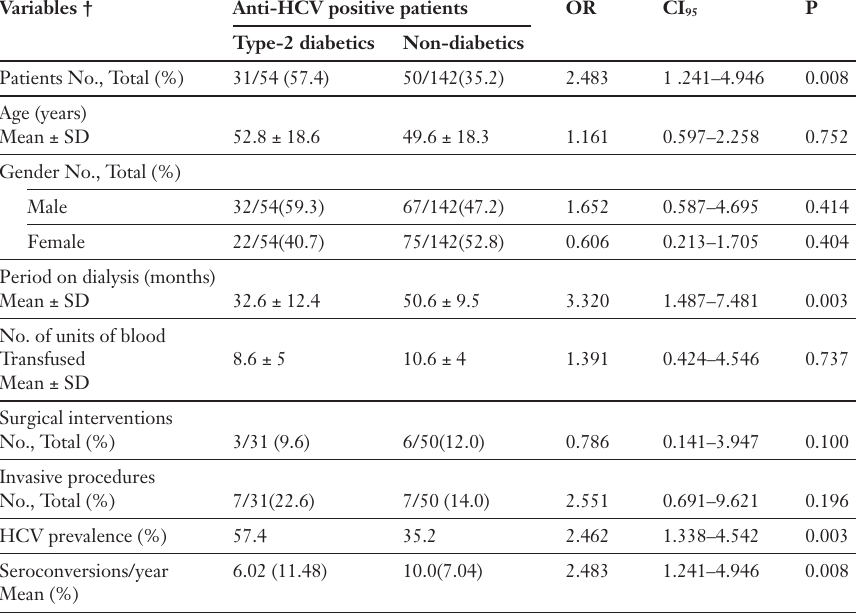
Mean HCV prevalence and seroconversion rates in Non-dia- betic and Type-2 diabetic (NIRDM & IRDM) patient groups on long-term HD. NIRDM – non insulin requiring diabetes melli- tus, IRDM – insulin requiring diabetes mellitus.